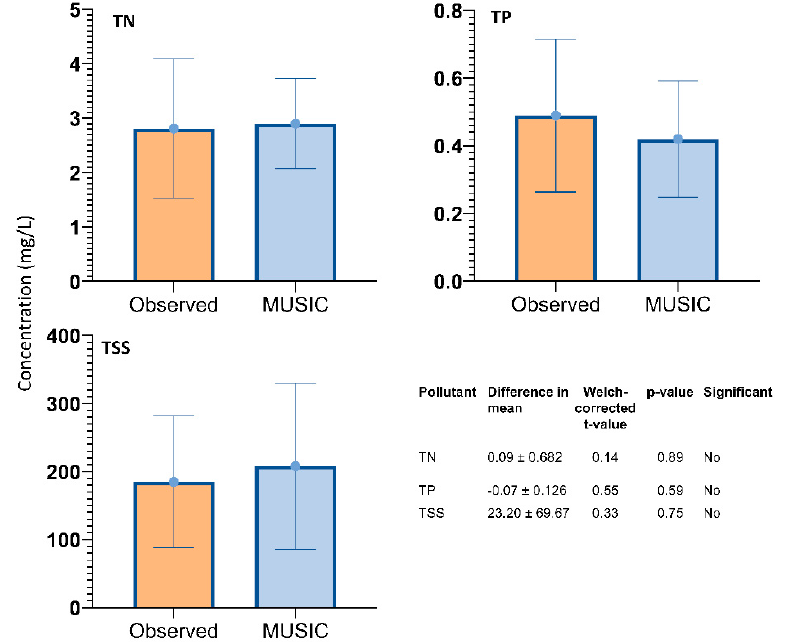
Figure 8. Analyzing the ability of MUSIC to simulate targeted pollutants using the stochastic generation process based on default values. Table 5. Adopted values for different parameters due to aggregation of wells in combined nodes.